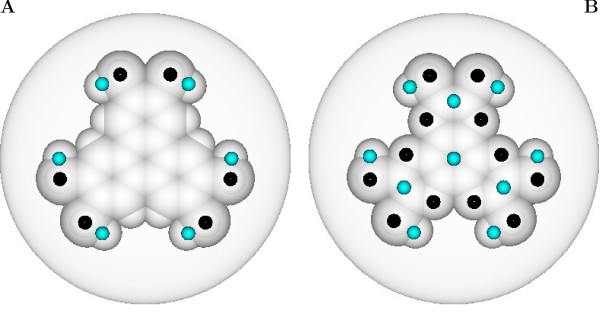
Electrostatic maps and point charges. Molecular van der Waals surface and optimal point charges positions represented on a disc with diameter equal to σee = 19.25 Å for HT-T (A) and HT-AT (B). Positive charges are shown in light blue, negative in black